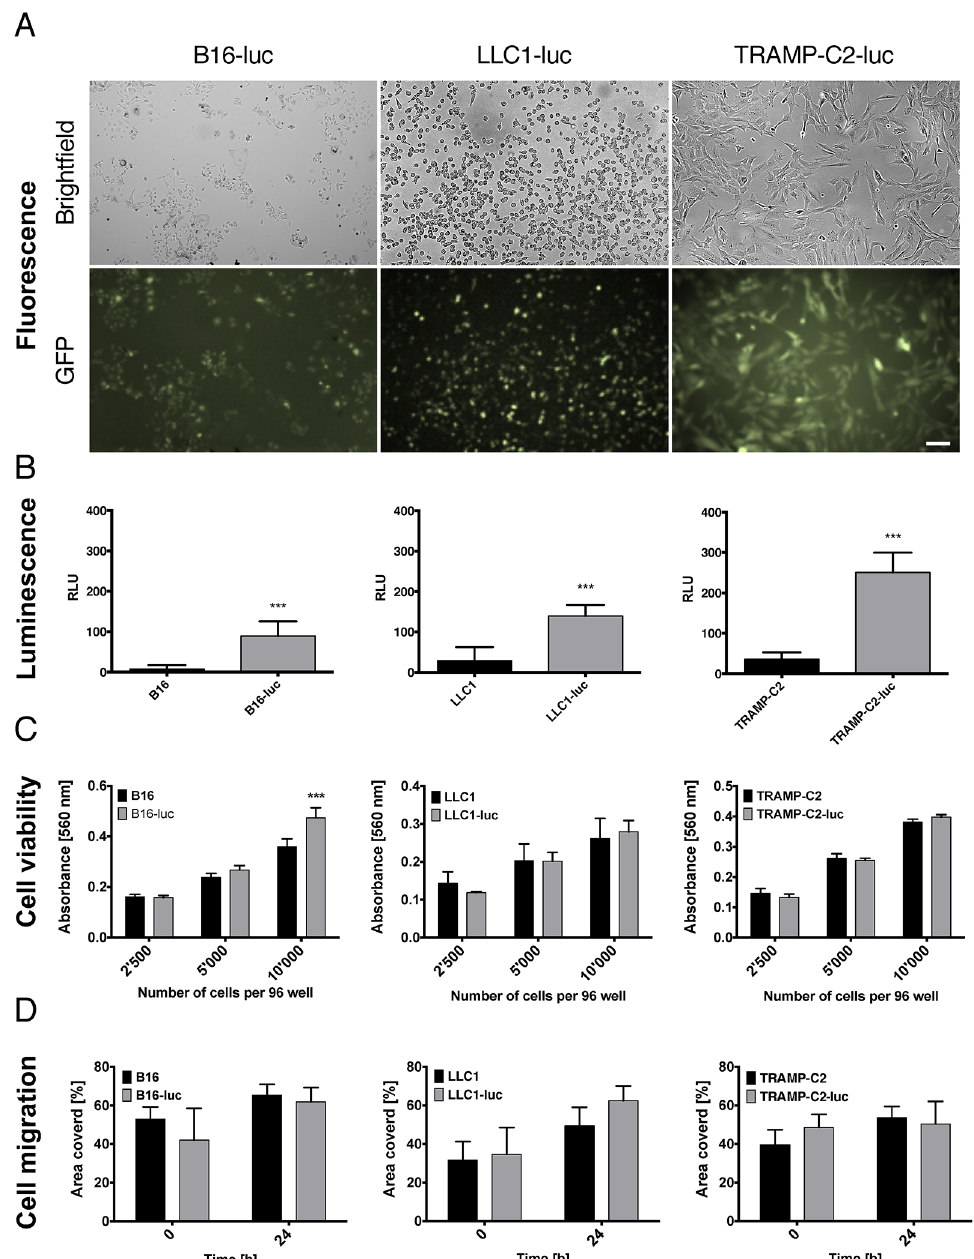
Fig 1. Characterization of firefly luciferase — eGFP infected B16-F1 melanoma, LLC1 lung carcinoma and TRAMP-C2 prostate carcinoma cells. (A) Cells were lentivirally transduced to express firefly luciferase, enhanced GFP and puromycin. Representative phase contrast and green fluorescence image of B16-luc, LLC1-luc and TRAMP-C2-luc cells (bar represents 100 μ m). (B) Analysis of luciferase activity by spectrometer demonstrates relative light units (RLU) emission by lysed cells. Bars represent mean ± SD, Student ’ s two tailed t-test (B16-luc vs. B16: p = < 0.0001, n = 7, LLC1-luc vs. LLC1: p = < 0.0001, n = 6, TRAMP-C2-luc vs. TRAMP-C2: p = < 0.0001, n = 6). (C) Viability was measured by absorbance of MTT. The absorbance was significantly higher in B16-luc cells seeded at 10 ’ 000 cells per well compared to control B16 cells (p < 0.0001). There was no viability difference in LLC1-luc and TRAMP-C2-luc cells compared to LLC1 and TRMAP-C2 cells respectively. Mean ± SD, n = 5 for all experiments shown, two way ANOVA with Bonferroni post hoc analysis. (D) Wound healing 2D migration analysis shows no difference in B16-luc, LLC1-luc andTRAMP-C2-luc cell migration 24 hours post scratch. Mean ± SD, n = 3 for all experiments shown, two way ANOVA with Bonferroni post hoc